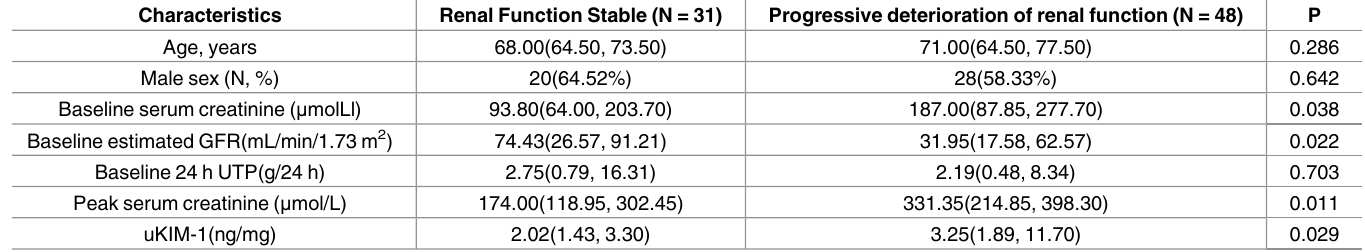
Table 5. Comparison between the progressive deterioration of renal function group and the renal function stable group after the one year of fol- low-up for elderly patients with AKI. Characteristics